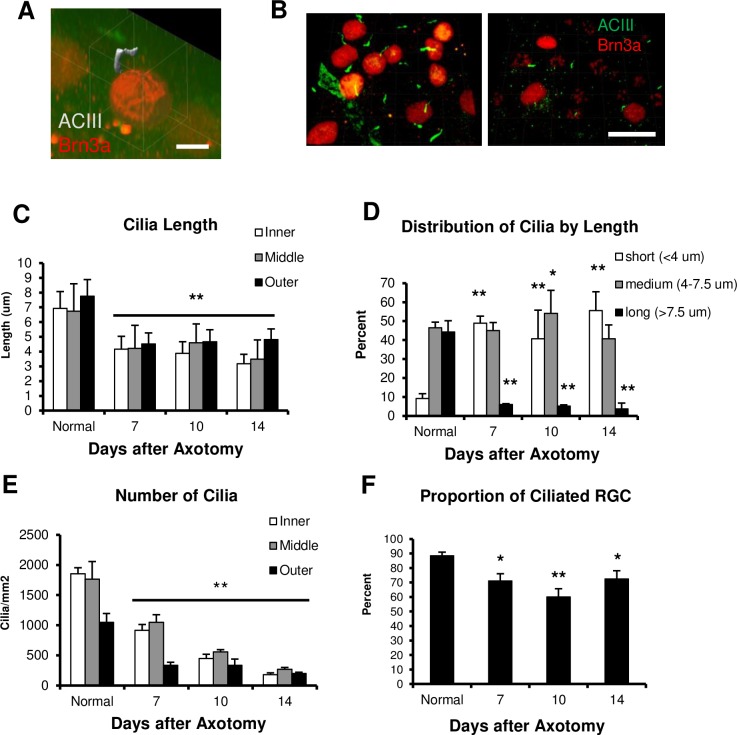
ONT induces ciliary shortening in RGCs.(A) Representative image of 3D voxel generation of an immunostaining for cilia (gray) and RGC nuclei (red) used in cilia quantification. (B) Left: Representative image of an immunofluorescent Z-stack of a naïve retina showing RGC nuclei (red) and cilia (green). Right: Representative image of an immunofluorescent Z-stack of the retina at 14 days post ONT. Scale bar = 20 μM. (C) The mean length of RGC primary cilia (μM) ± SEM, before and after ONT. **p<0.01. (D) Quantification of RGC cilia in normal and axotomized retinas, stratified by length. ONT induced a significant increase in the proportion of short cilia and a drastic decrease in the proportion of long cilia at each time point after ONT. **p<0.01. *p<0.05. (E) The average number of RGC primary cilia ± SEM quantified before and after ONT. **p<0.01. (F) The average percentage of ciliated RGCs ± SEM. Ciliated RGCs were significantly reduced after axotomy indicating complete loss of cilia in some RGCs following injury (*p<0.05, **p<0.01). A total of >50 cilia were measured for each group, n = 3 retinas per group.